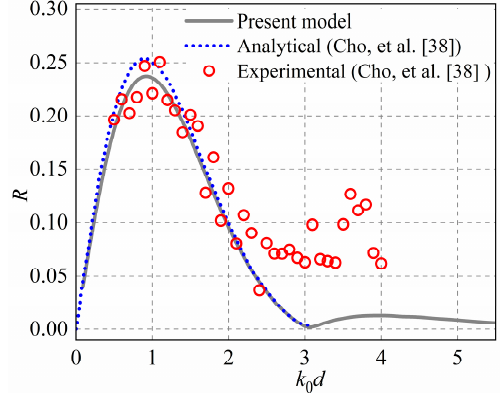
Figure 5. Comparison between present method and existing results [38] of rectangular obstacle on seabed.